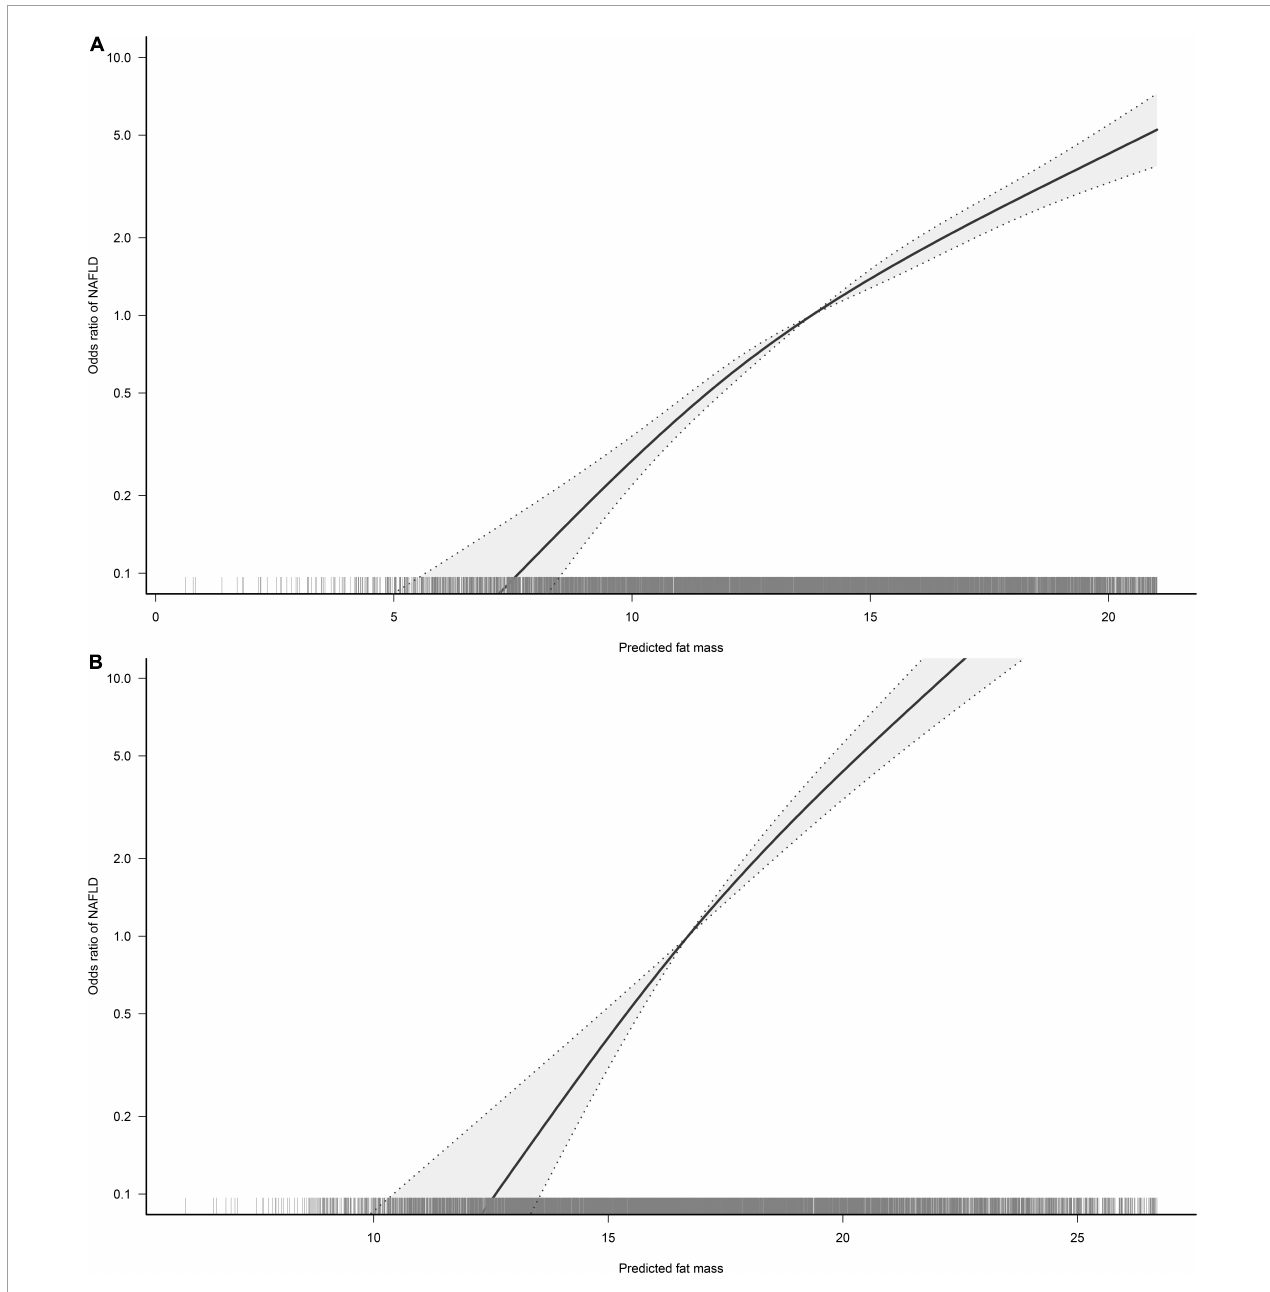
FIGURE3 Restricted cubic spline analysis of predicted fat mass (FM) for the estimation of the risk of non-alcoholic fatty liver disease (NAFLD) in men (A) and women (B) . Adjusted for age, exercise habits, drinking status, smoking status, ALT, AST, GGT, FPG, HbA1c, TC, TG, HDL-C, and